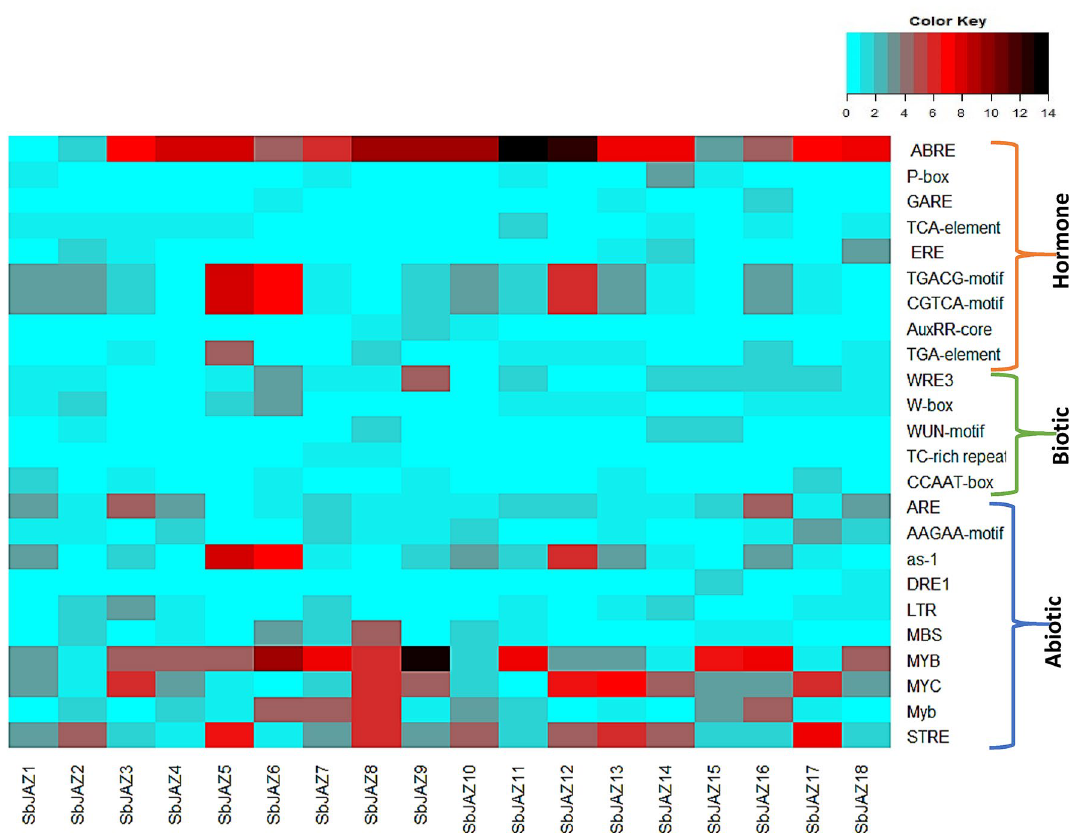
Figure 6. Heatmap representing the distribution of cis -elements in the promoter regions (2000 bp upstream) of sorghum JAZ genes. The scale (color key) represents the number of cis-elements in each SbJAZ genes (1: sky blue, 7: red, 14: